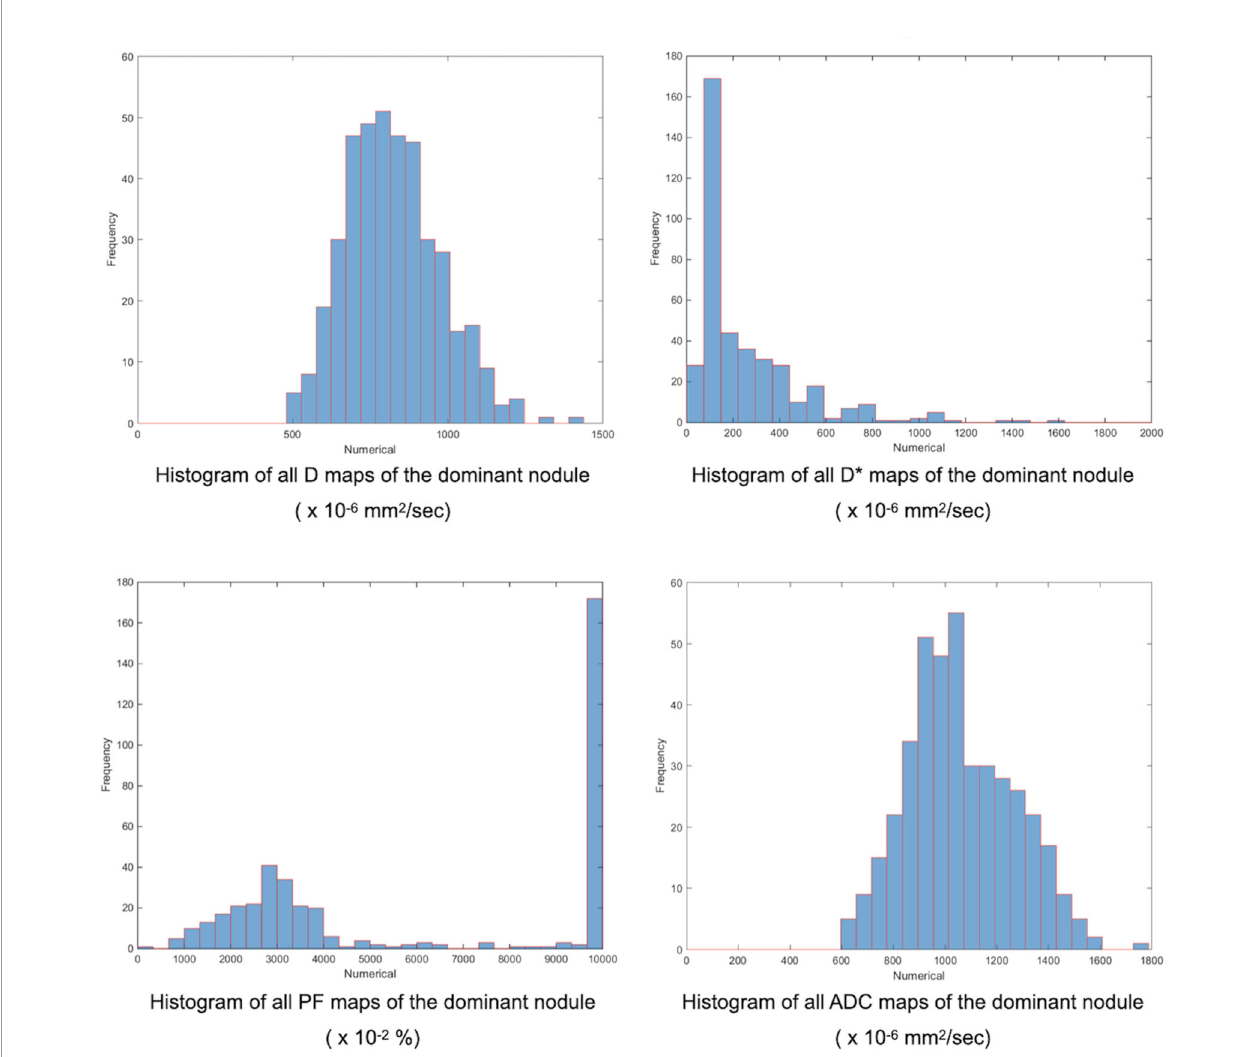
FIGURE 4 | Finally, our homemade software constructed the whole dominant nodule histograms for D, D*, PF, and ADC by combining the different histograms from each image. The minimum, mean, and kurtosis of the IVIM/ADC parameters were extracted from the whole dominant nodule histogram and used for further